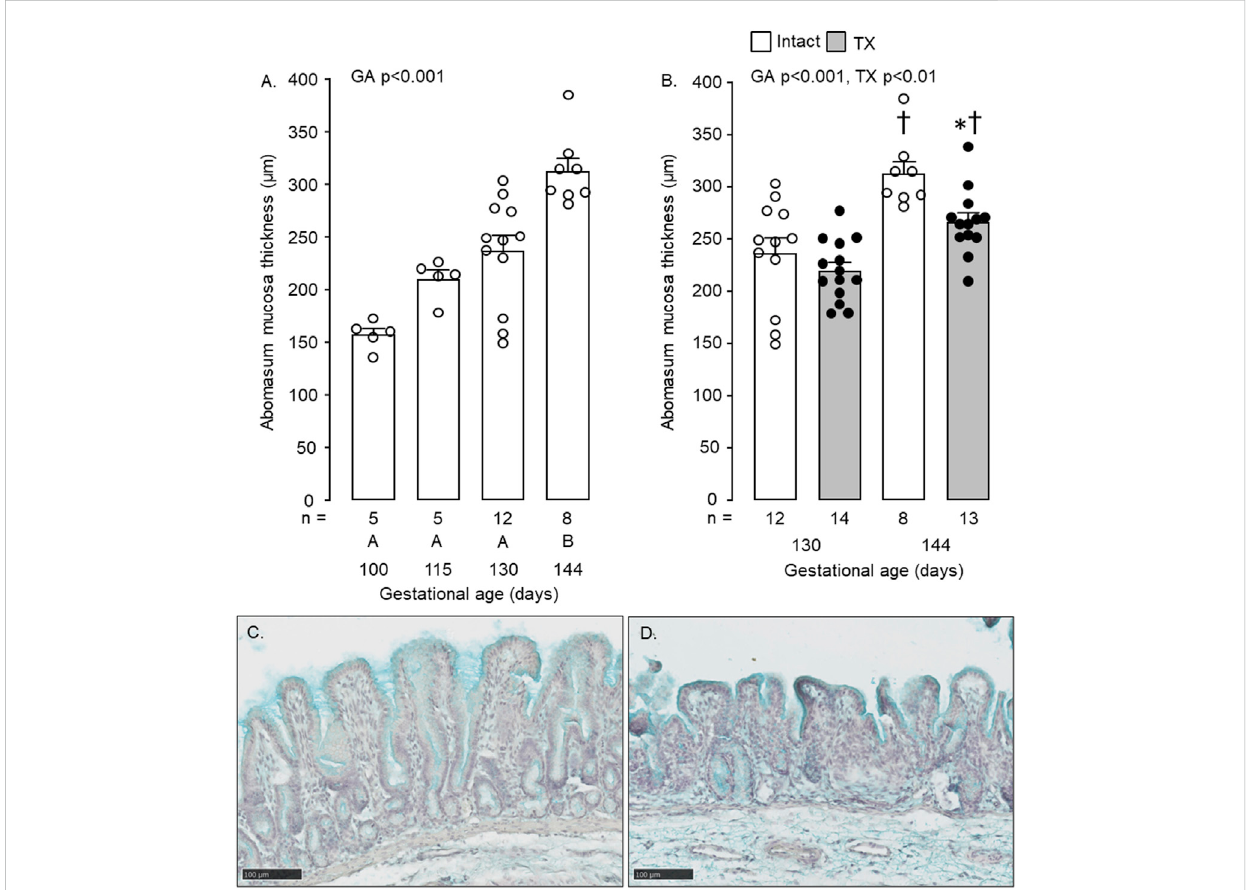
FIGURE 5 Mean (±SEM) and individual mucosal thickness intheabomasum of (A) theintact fetuses studied between 100 and 144 days of gestation and (B) the intactandTXfetusesat130and144 daysofgestation.InFigure5A,valueswithdifferentlettersatthebaseofthehistogramaresigni fi cantlydifferentfrom each other ( p < 0.05, one-way ANOVA). In Figure 5B, *, signi fi cant difference from intact fetuses at the same gestational age ( p < 0.05); † , signi fi cant difference from fetuses of the same treatment at 130 days of gestation ( p < 0.05). Numbers of fetuses in each group are indicated at the base of